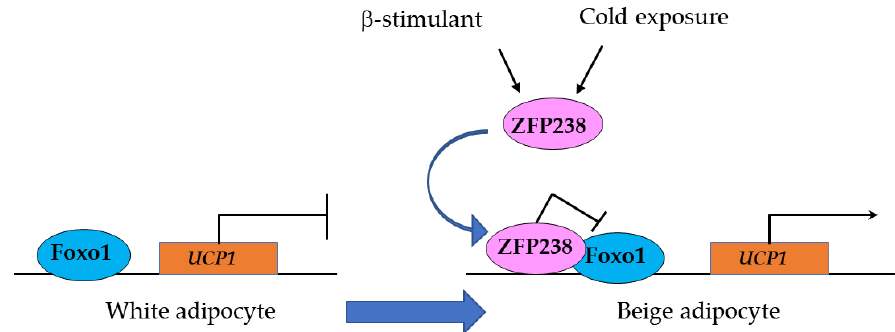
Figure 5. Zfp238 acts as a Foxo1 corepressor and regulates Ucp1 expression. In response to cold exposure and β -stimulant, Zfp238 binds to the promoter region of Ucp1 through Foxo1 and induces Ucp1